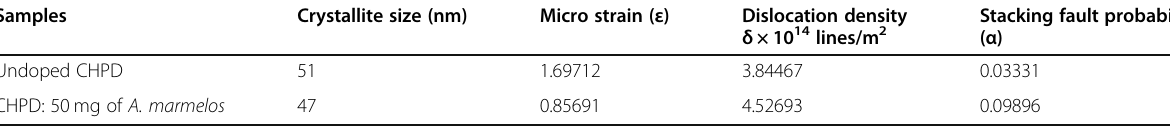
Table 3 Microstructural parameters of undoped and A. marmelos added CHPD crystals